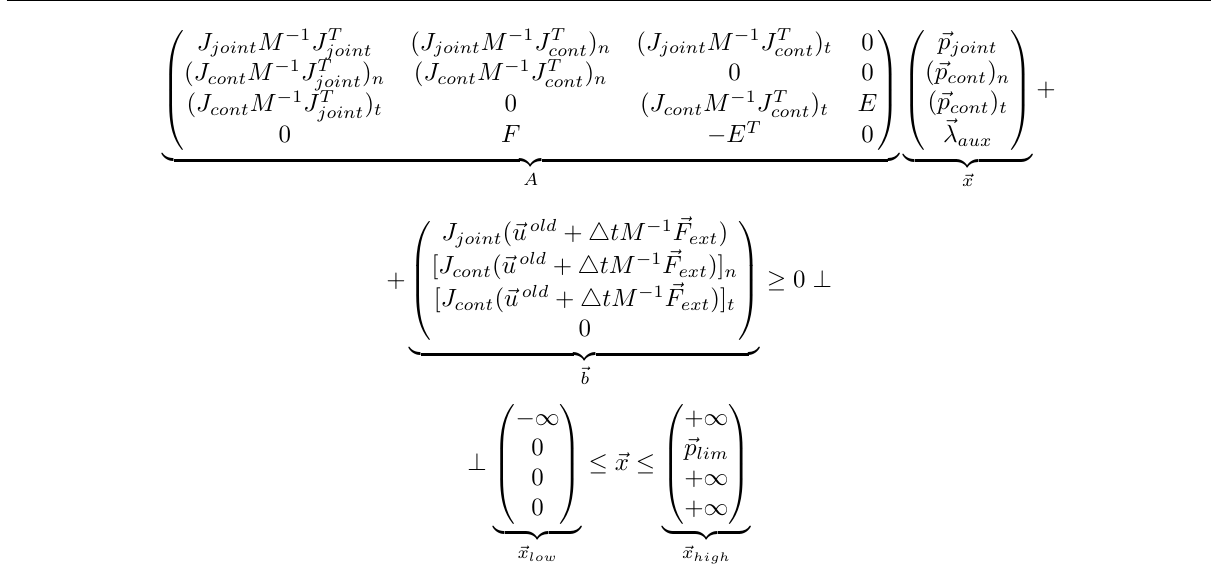
Figure 19: Complementarity conditions on system level in matrix